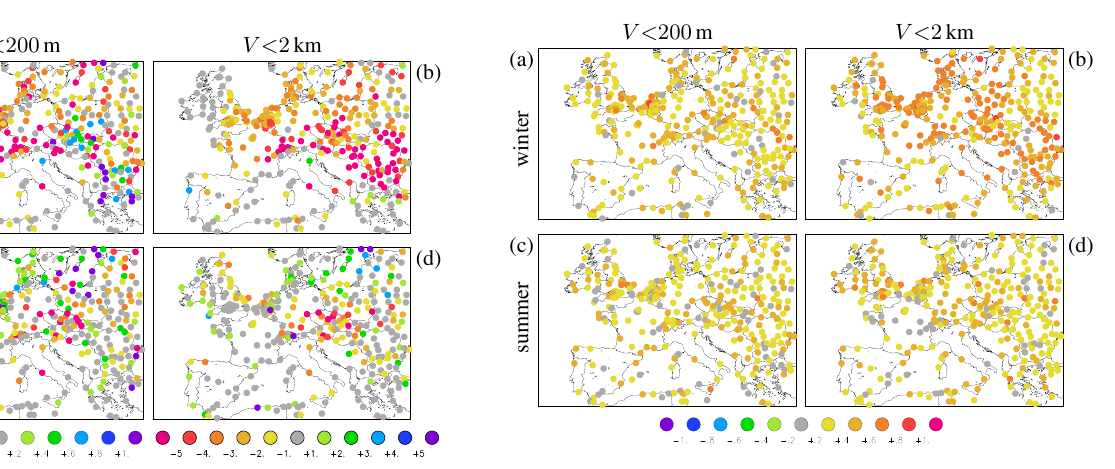
Fig. 15. The correlation of the VSM Eq. (1) without noise with the observed number of days of dense fog (a) and (c) , and 2km mist (b) and (d) , in winter (a) and (c), and summer (b) and (d).